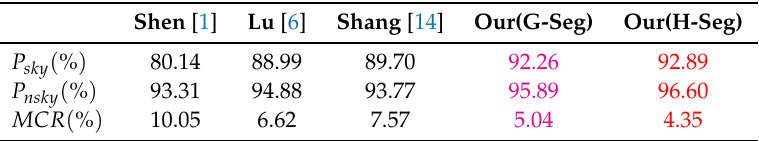
Table 2. Detection rate and misclassification rate on the HazySky dataset. In the similarity measurement step, we set the feature weights experimentally as ω 1:9 = [ 0.3,0.4,0,0,0.2,0,0,0,0.1 ] and set N th _ adj = 1% of the total number of pixel in the image. Shen [1] Lu [6] Shang [14] Our(G-Seg)